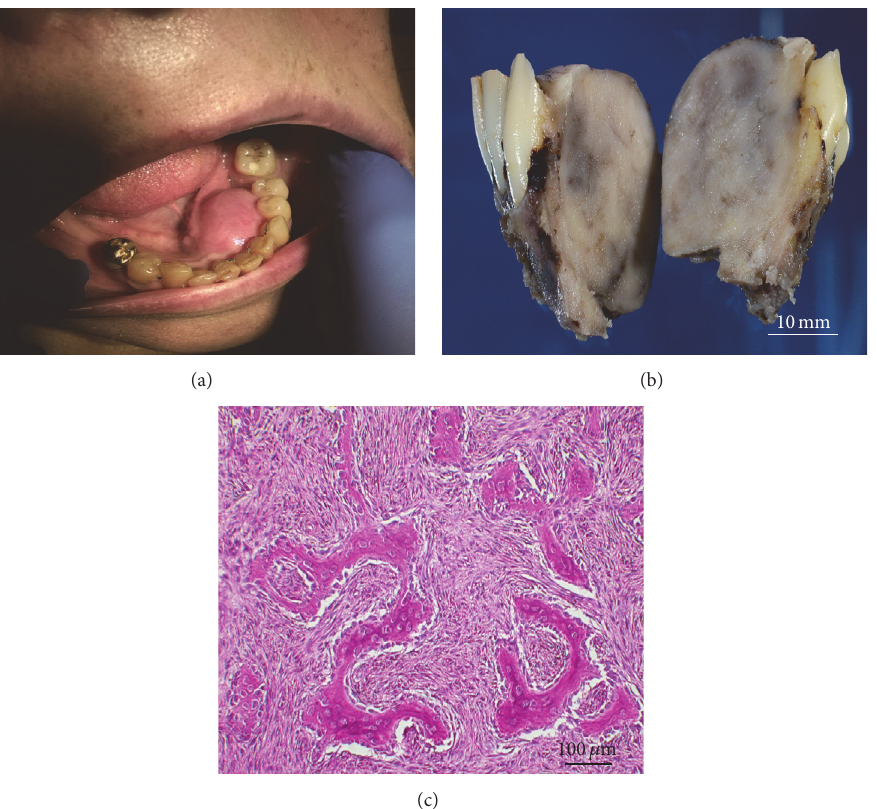
Figure 1: (a) View of the patient’s oral cavity. (b) Cross-section through the partial mandibulectomy specimen, showing a well-delineated tumor pushing away the tooth roots. (c) Light microscopy shows a cellular fibrous stroma containing irregular woven bone trabeculae looking like Chinese letters, lined by many swollen osteoblasts, characteristic features of ossifying fibroma.